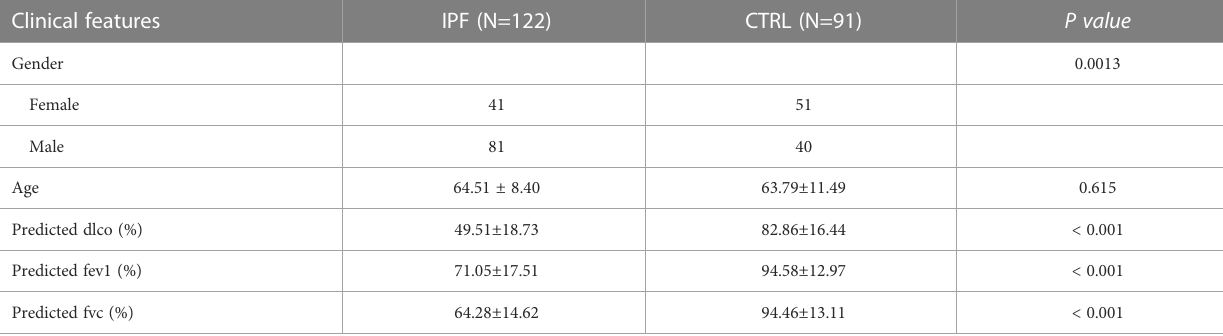
TABLE 1 The baseline characteristics of the study subjects. Clinical